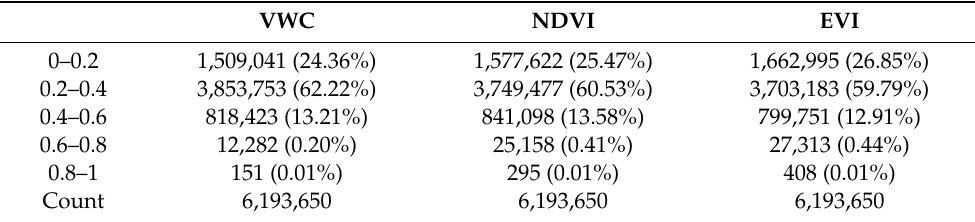
Table 5. Pixel number of each interval of soil moisture